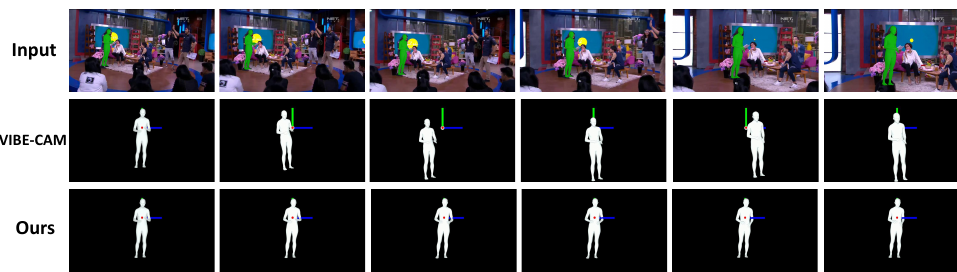
Figure 7. Vertex error over time. The numbers in the graph represent the vertex error between the predicted human mesh and its ground-truth in the world coordinate system.